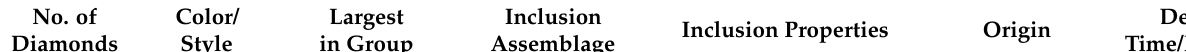
Table 2. Summary of inclusions observed in type IIa colorless